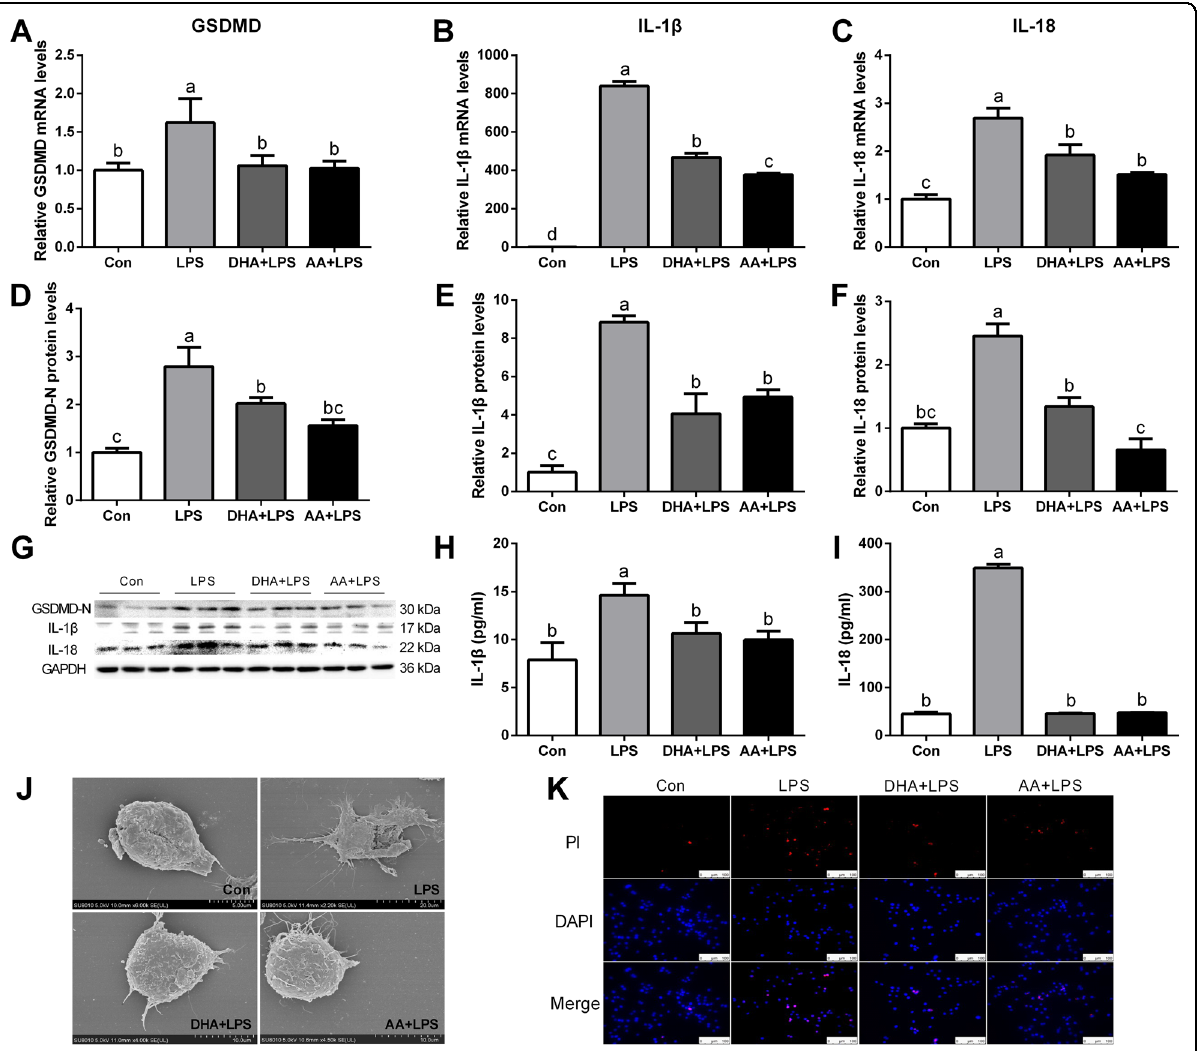
Fig. 2 DHA/AA inhibited the expression of GSDMD, IL-1 β and IL-18, and cell in fl ammatory death in LPS-induced Kupffer cells. A – C Kupffer cells were pretreated with 50 μ M DHA/AA for 4 h and then were treated with 100 ng/mL LPS for 6 h. The mRNA levels of GSDMD, IL-1 β , and IL-18 were determined by quantitative real-time PCR. D – G Kupffer cells were pretreated with 50 μ M DHA/AA for 4 h and then were treated with 100 ng/ mL LPS for 12 h. The protein levels of GSDMD, IL-1 β , and IL-18 were determined by western blot analysis. H , I Levels of IL-1 β and IL-18 in the supernatant were measured by ELISA . J The cell morphology was observed and imaged under a scanning electron microscope (SEM). K PI staining was used in immuno fl uorescence (scale bar, 100 μ m). In the bar graph, data represent the means ± SEM, n = 3 per group. Mean values not sharing the same letters are signi fi cantly different, P <